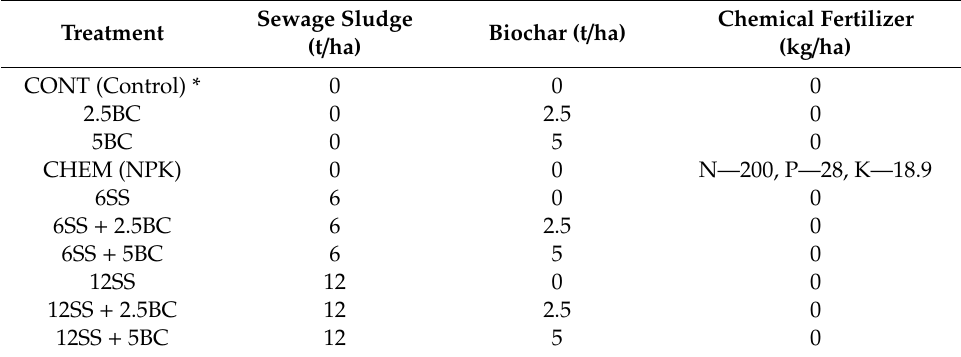
Chemical Fertilizer (kg /